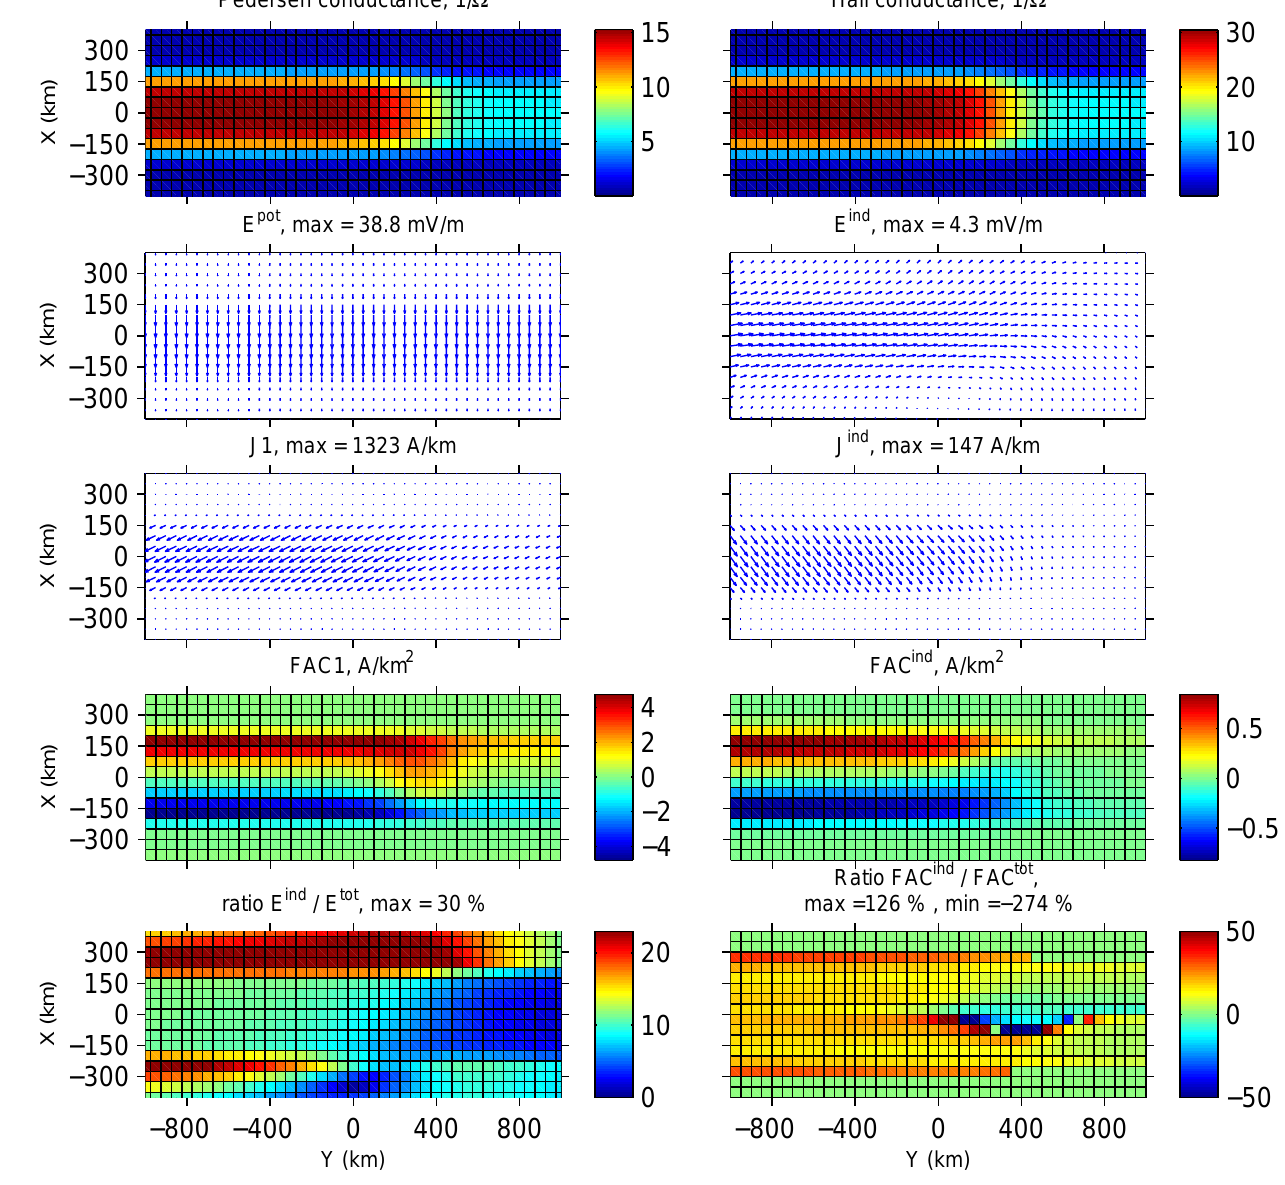
Fig. 5. The input electrojet model (Pedersen and Hall conductances, potential electric field E pot with current system J 1 and FAC1) and the calculated induced electric field ( E ind ) and current system ( J ind and FAC ind ) at time instant t = 40s. Comparison between the induced and total (input + induced) electric field and FAC are also